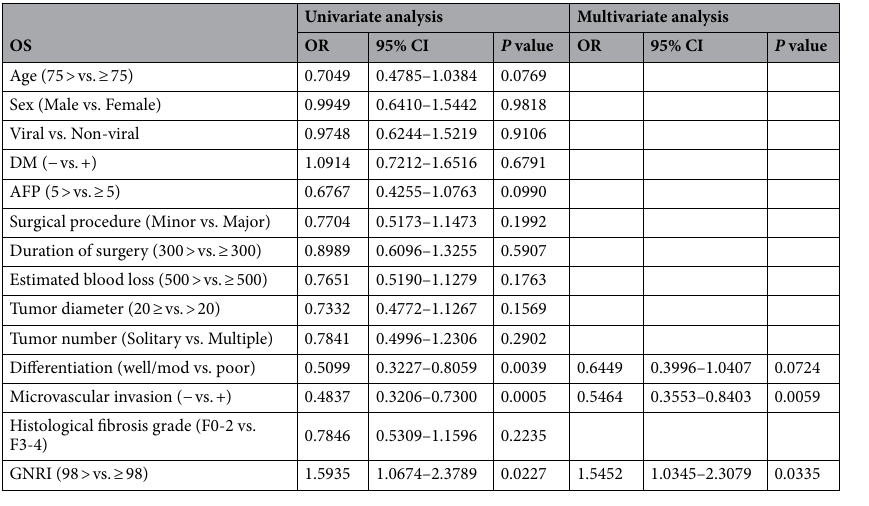
Table 3. Univariate and multivariate analyses of overall survival. AFP: alpha-fetoprotein, CI: confidence interval, DM: diabetes mellitus, GNRI: geriatric nutritional risk index, OR: odds ratio, OS: overall